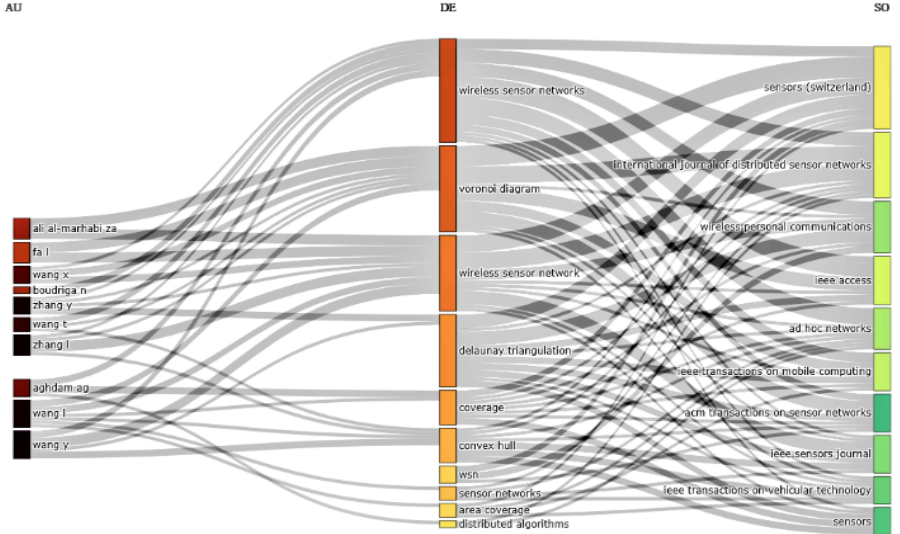
Figure 7. A three-field plot of authors, keywords, and publication sources.